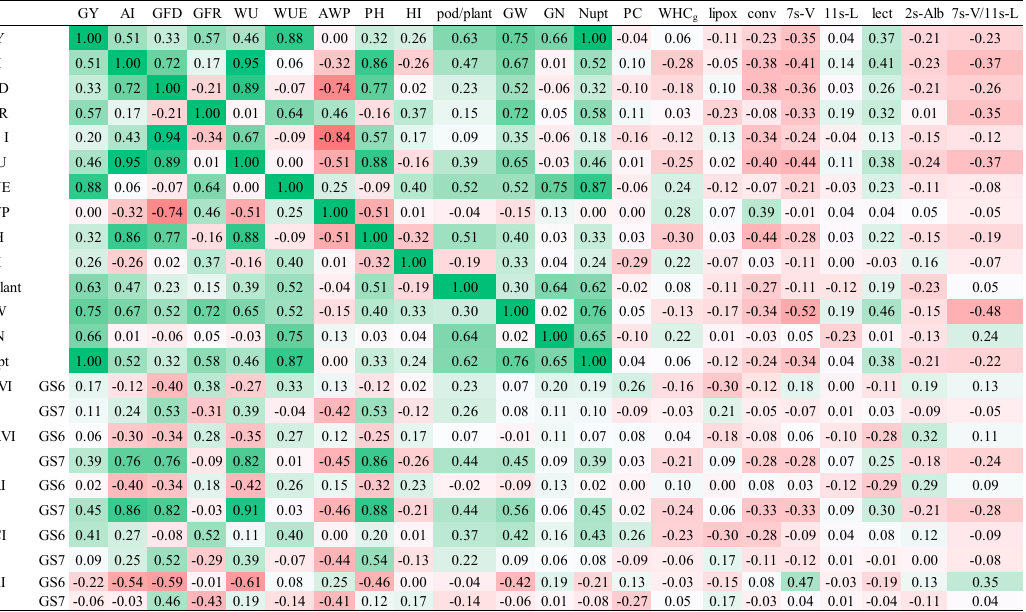
Figure 2. Pearson’s correlation matrix between (heatmap) investigated crop physiological, agronomic, and quality traits on chickpea genotypes under a range of environmental and agronomic conditions. Abbreviations are as follows: GFR = grain filling rate; WUE = water use efficiency; AWP = agricultural water productivity; GY = seed yield; PH = plant height; HI = harvest index; GW = grain weight; GN = seed/m 2 ; Nupt = N uptake; NDVI = normalized difference vegetation index; OSAVI = optimized soil-adjusted vegetation index; LAI = leaf area index estimated from enhanced vegetation index; PRI = photochemical reflectance index; PC = protein content; WHC g = grain water-holding capacity; lipox = lipoxygenase; conv = convicilin; 7s-V = 7s vicilin; 11s-L = 11s legumin; 2s-Alb = 2s albumin; 7s-V/11s-L = ratio between 7s vicilin and 11s legumin. Red and green represent low and high R values; values are statistically significant, at p < 5%, with R > ± 0.26.